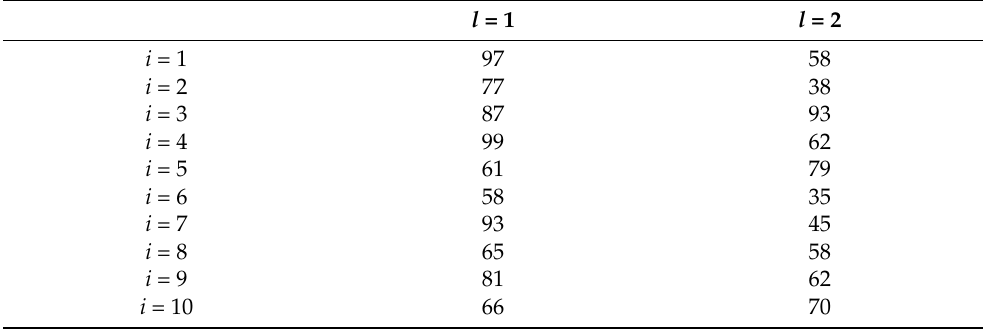
Table 11. Linear distance of DU li.